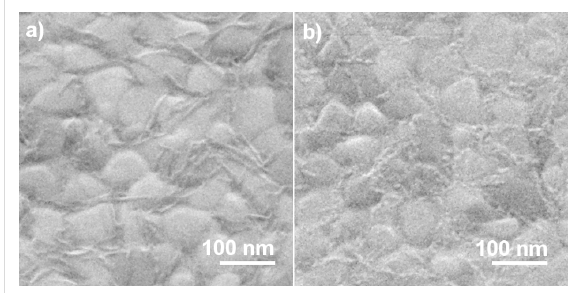
Figure 6: HIM images of samples after different steps of preparation and electron exposure. (a) Au substrate covered first with carboxy- terminated SAM and then with copper(II) oxalate prepared by four deposition cycles and (b) an analogous sample after electron expo- sure of 16000 μ C/cm 2 at 50 eV.